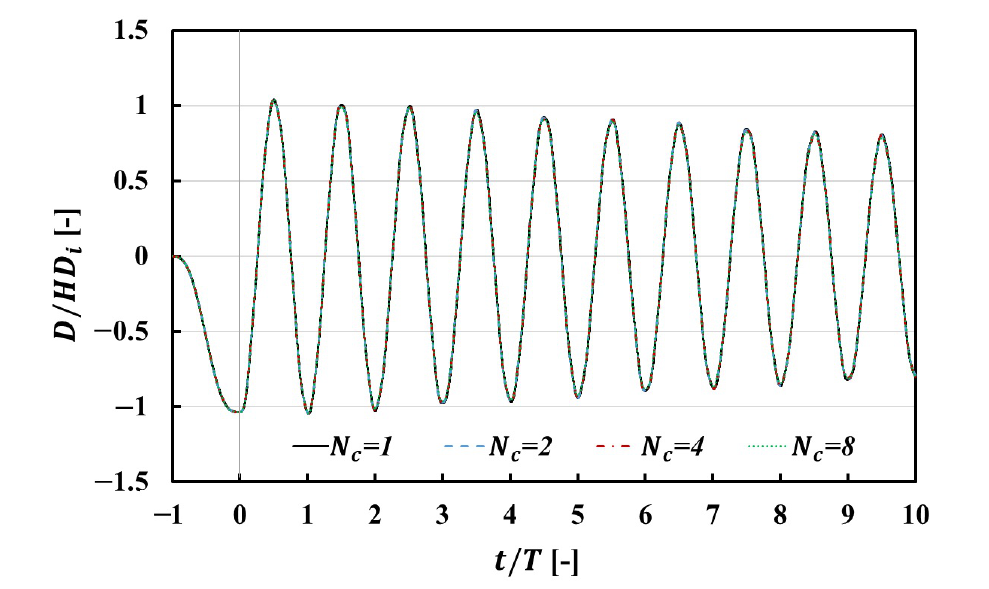
Figure 23. Time history of non-dimensional tip vertical displacement of the system normalised by the initial excitation amplitude over ten cycles for D i =